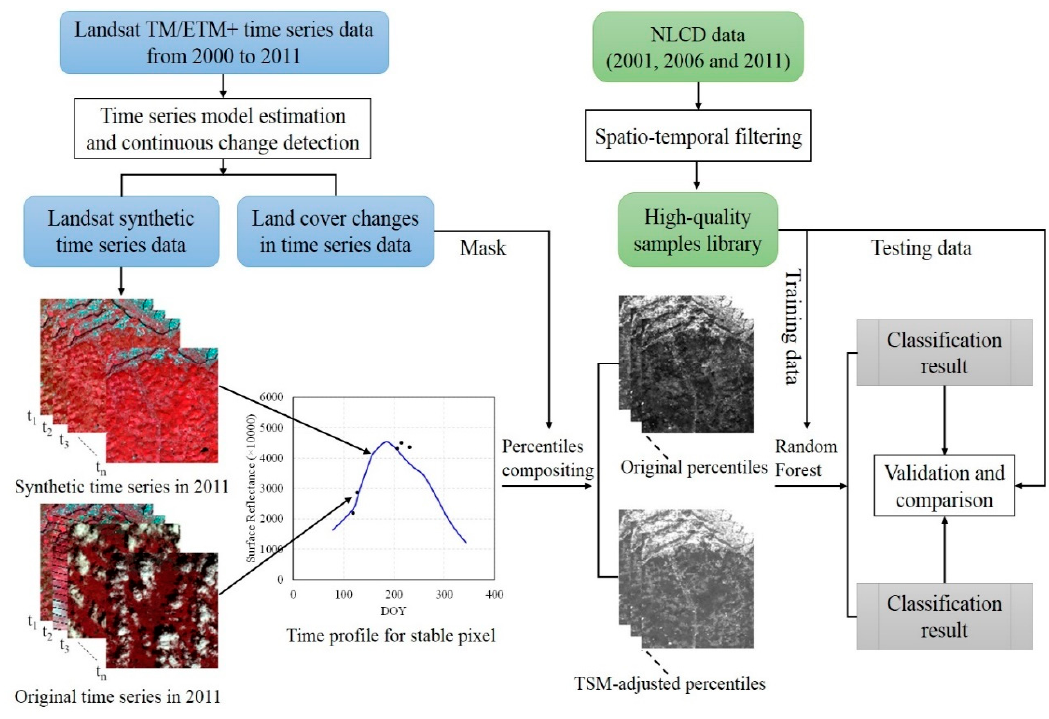
Figure 2. Flowchart of the proposed method.